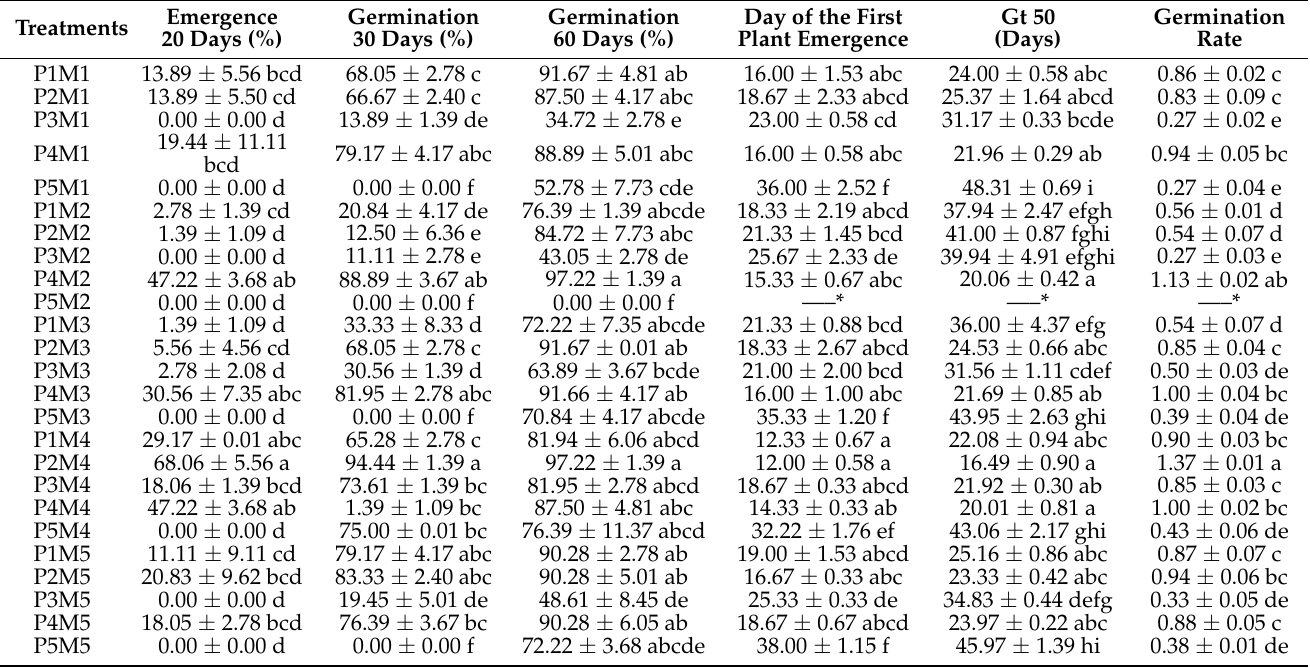
Table 2. Interaction genotype (P) × priming method (M) for the germination